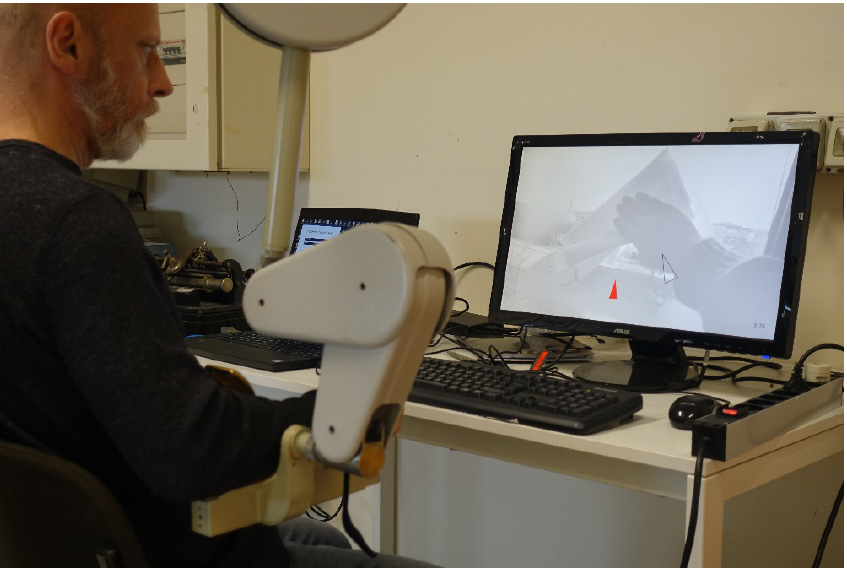
Figure 9. Rear view of the system, with red key-point and 3D cursor displayed on the subject’s monitor.